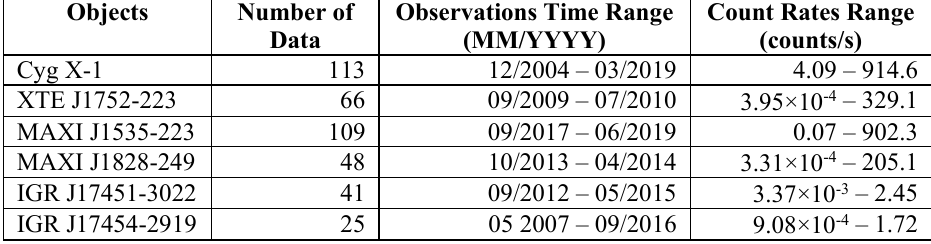
Table 1. The comparison of amount of data, observation period, and count rates range of black hole candidates with Cyg